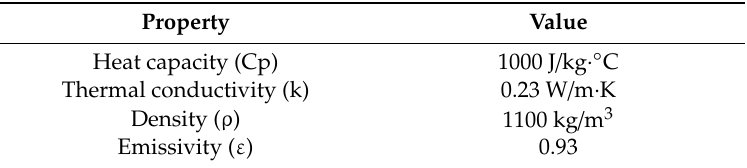
Table 1. Physical properties of roofing